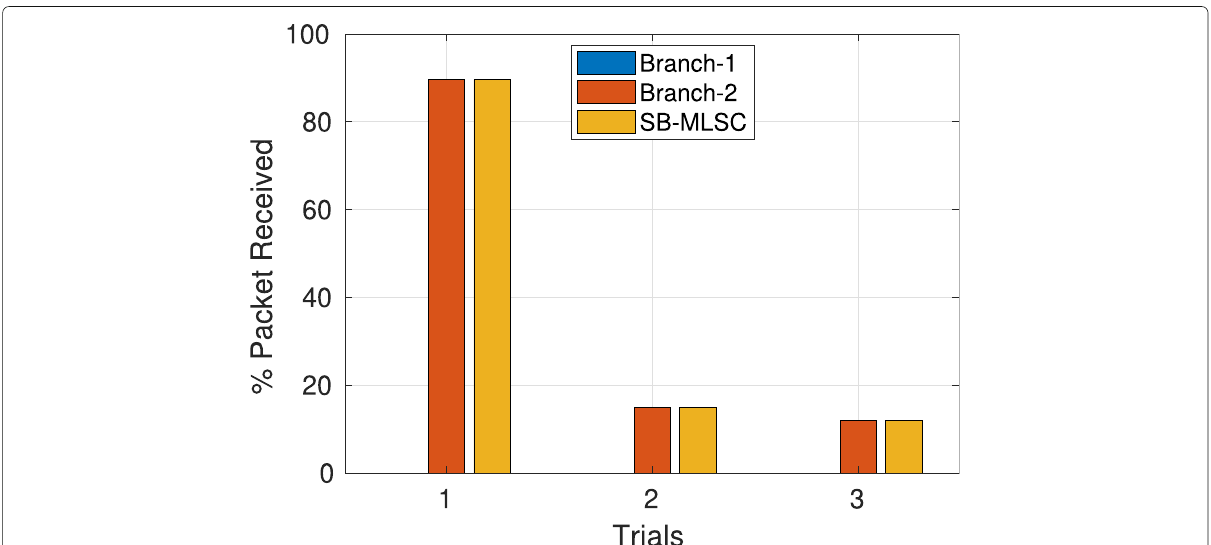
Fig. 21 Branch 1 is fully covered with aluminum foil and hence ceases to receive any packet. In this case, SB-MLSC tracks branch 2 when branch 1 is killed